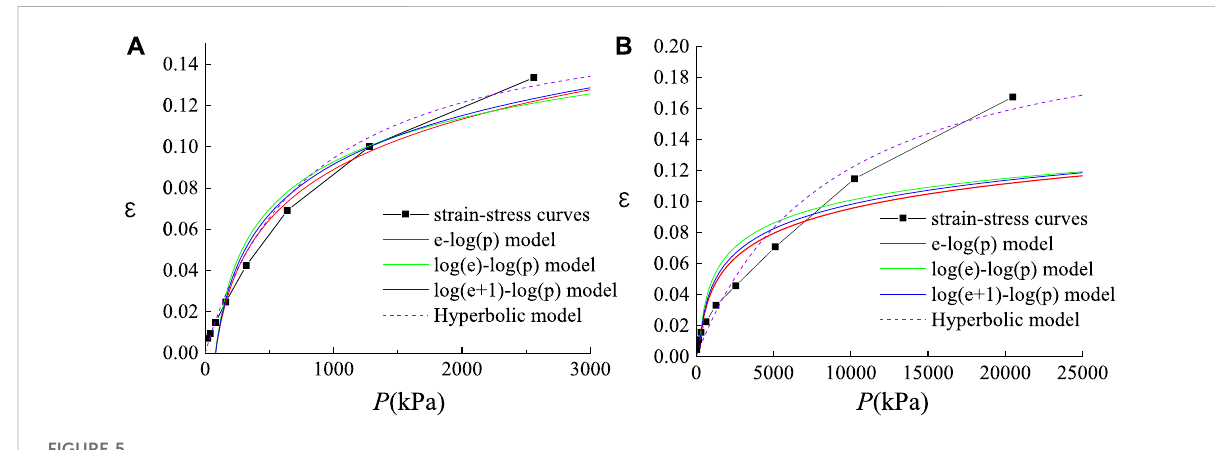
FIGURE 5 The strain-stress curves with comparisons to the compression models at sampling depths of 29.6 m (A) and 292.3 m (B) .